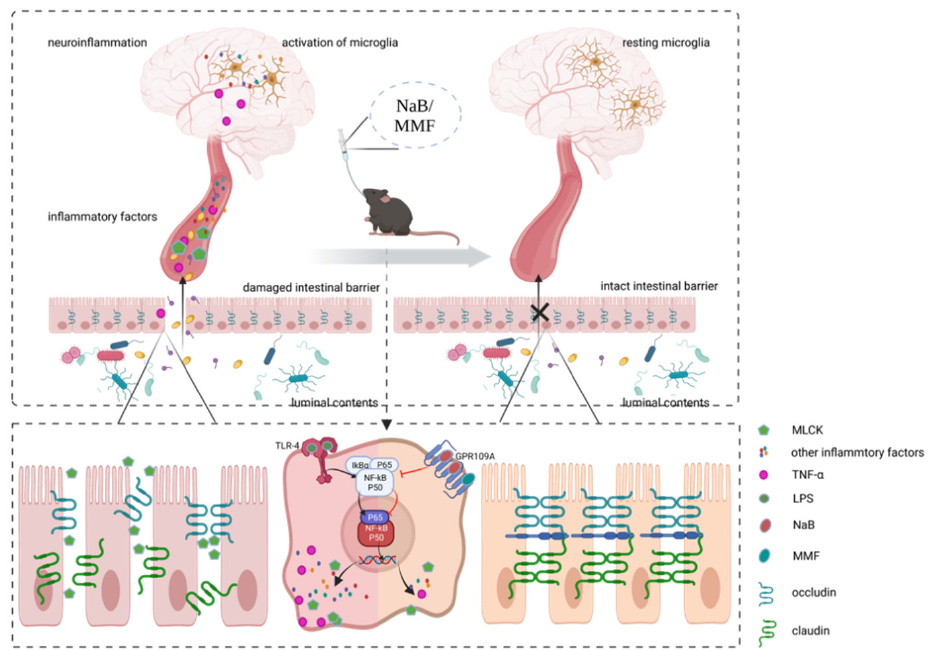
Figure 9. An illustration of the mechanisms. In MPTP-induced PD mice, therapy with NaB or MMF exerted neuroprotective benefits against neuroinflammation and neurodegeneration via stimulating GRP109A and restoring the intestinal barrier. NaB, sodium butyrate; MMF, monomethyl fumarate; MPTP, 1-methyl-4-phenyl-1,2,3,6-tetrahydropyridine; PD, Parkinson’s disease; GPR109A, G-protein-coupled receptor 109A.